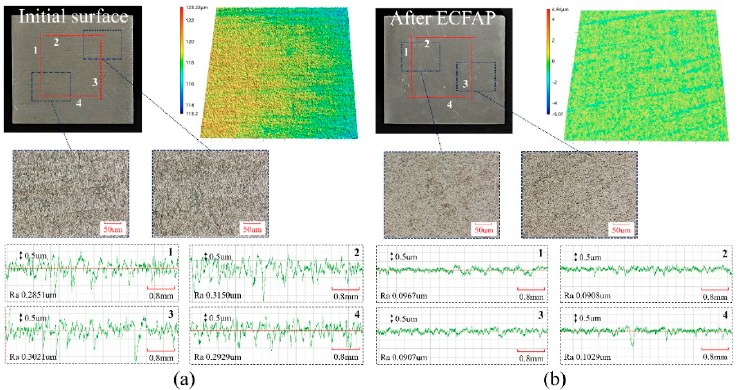
Figure 16. Comparison of samples before and after ECFAP: ( a ) 3D morphology and roughness profile of initial; ( b ) ECFAP-treated surfaces.